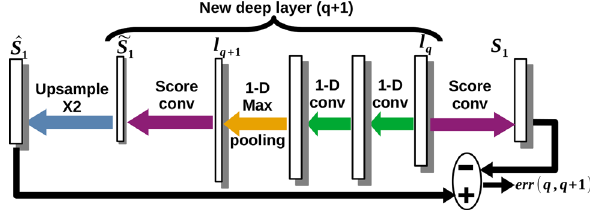
Fig. 7 IDI module which increases the deep layers of 1D-CNN while measuring the error of this